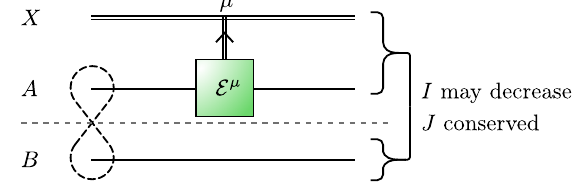
FIG. 6. Circuit representation of a local SI operation on a bipartite system AB . When an outcome E μ is obtained by selecting a result μ from the ancilla measurement in the dilation (Result 1), μ is recorded in a classical memory X . Retaining X , the total correlations I ð AX ∶ B Þ cannot increase, but the classical correlations J ð B j AX Þ are